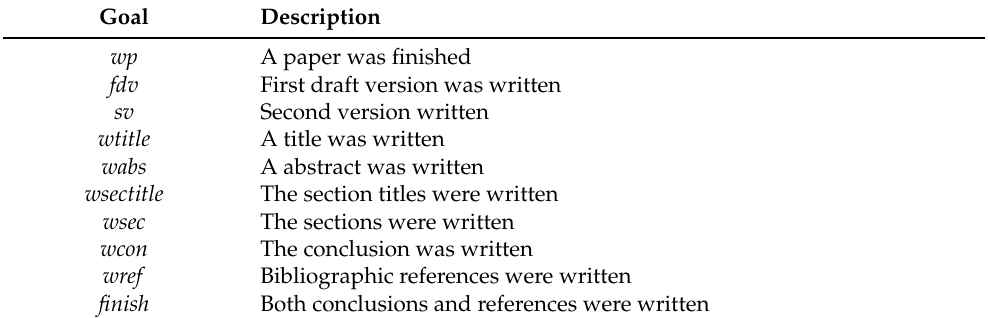
Table 3. Goals descriptions for Writing Paper